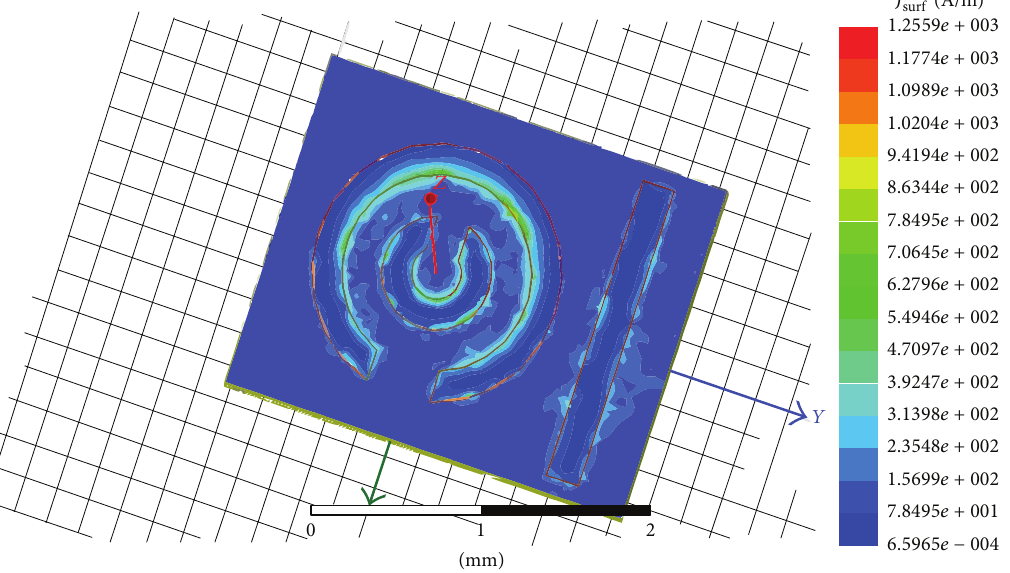
Figure 5: The distribution of the current around the wire and the SRR.